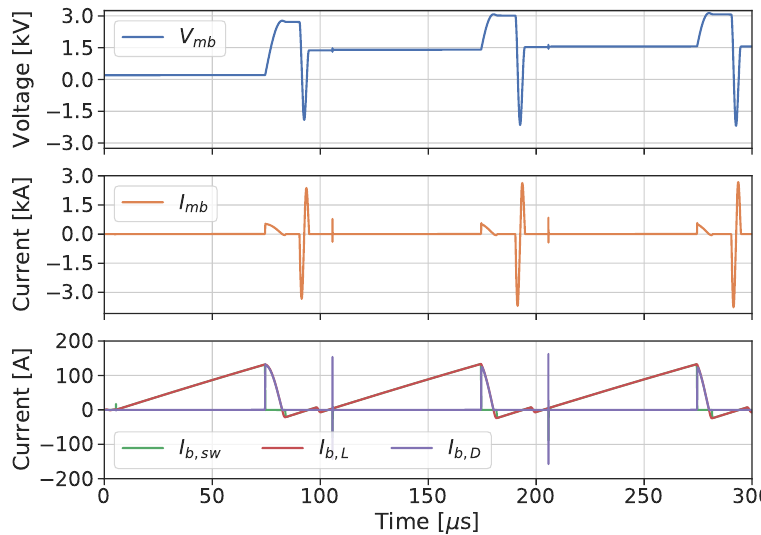
Figure 32. Simulated waveforms of the main bank voltage ( V mb ) and currents through the main bank ( I mb and each of the boost switches ( I b , sw ), inductors ( I b , L ), and diodes ( I b , D ) in the UW HiPeR-PIT